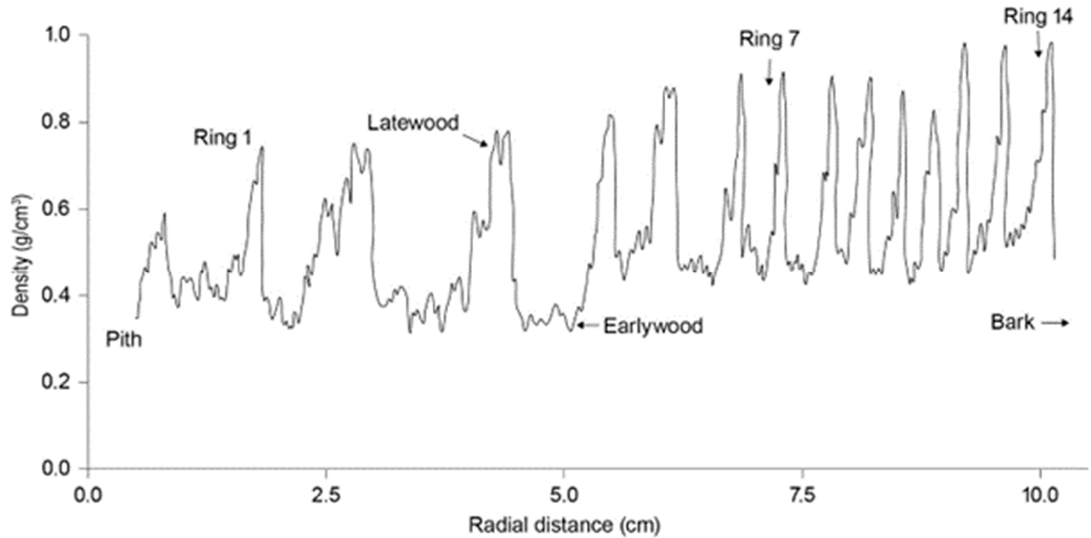
Figure 7. Pith-to-bark densiometric trace of P. radiata (redrawn from Bamber and Burley Figure 13 in [53]) showing both within-ring and corewood-to-outerwood trends.